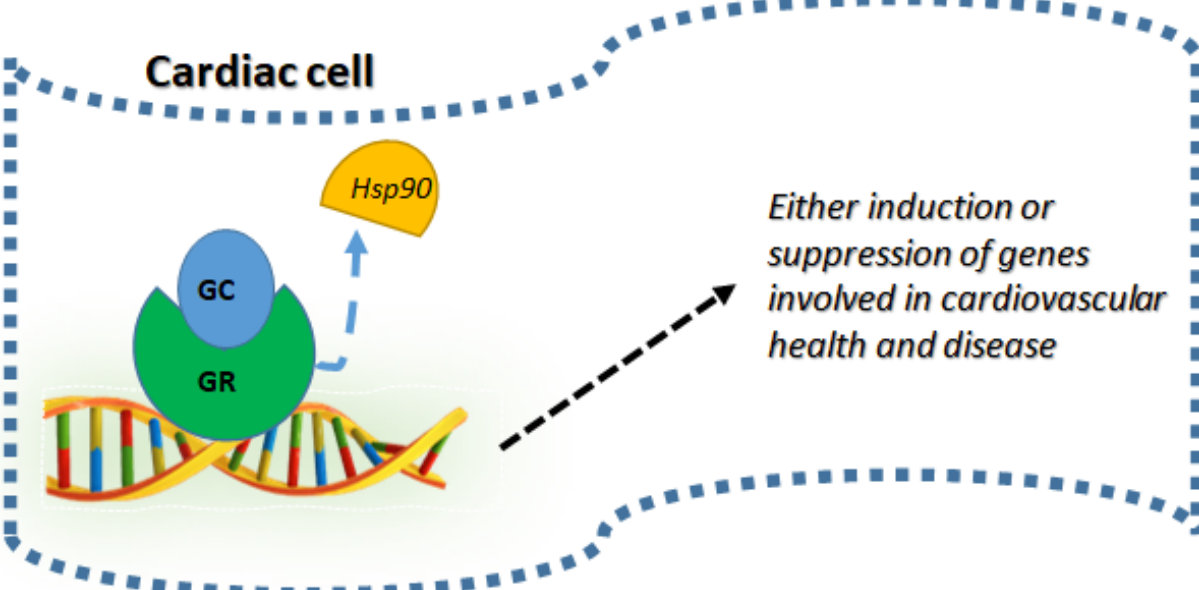
Figure 2. Cellular mechanism of GC on cardiovascular tissue: Following the ligand binding (GC) to GR, they detach from the chaperones such as heat shock protein 90 (Hsp90) undergoing nuclear translocation and DNA binding to either induce or suppress gene targets which are involved in cardiac health and